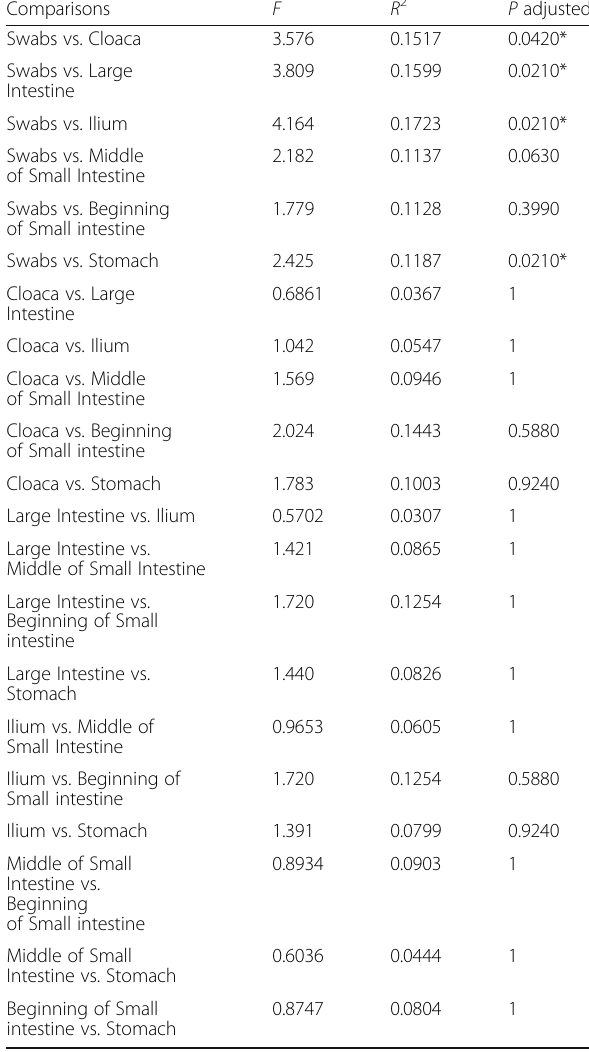
Table 1 The results of pairwiseAdonis analyses (Bray-Curtis distances) between gut microbial communities of different regions of the digestive tract, including cloacal swabs